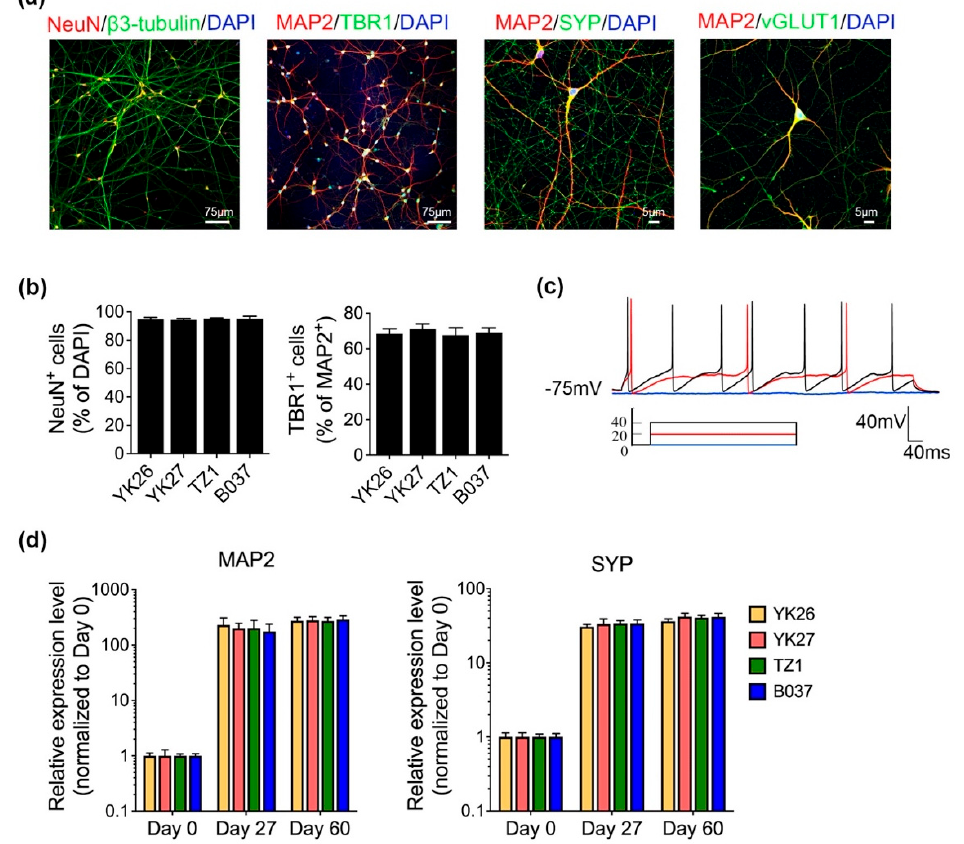
Figure 2. Characterization of mature cortical neurons. ( a ) Representative confocal images show neuronal markers expression on day 60: MAP2, β 3-tubulin, NeuN and TBR1. White scale bar, 75 µ m; synaptic markers expressed includes: synaptophysin (SYP) and vesicular glutamate transporter 1(vGLUT1). White scale bar, 5 µ m. ( b ) More than 95% cells are NeuN+ and around 70% cells are TBR1+ in the neuronal culture. At least five random fields were counted per coverslip. ( c ) Actional potential exists in day 60 neurons. n = 8–10 neurons were tested per coverslip. ( d ) Elevated mRNA levels of MAP2 and SYP over induction period. n = 4, data are presented as mean ± SEM.